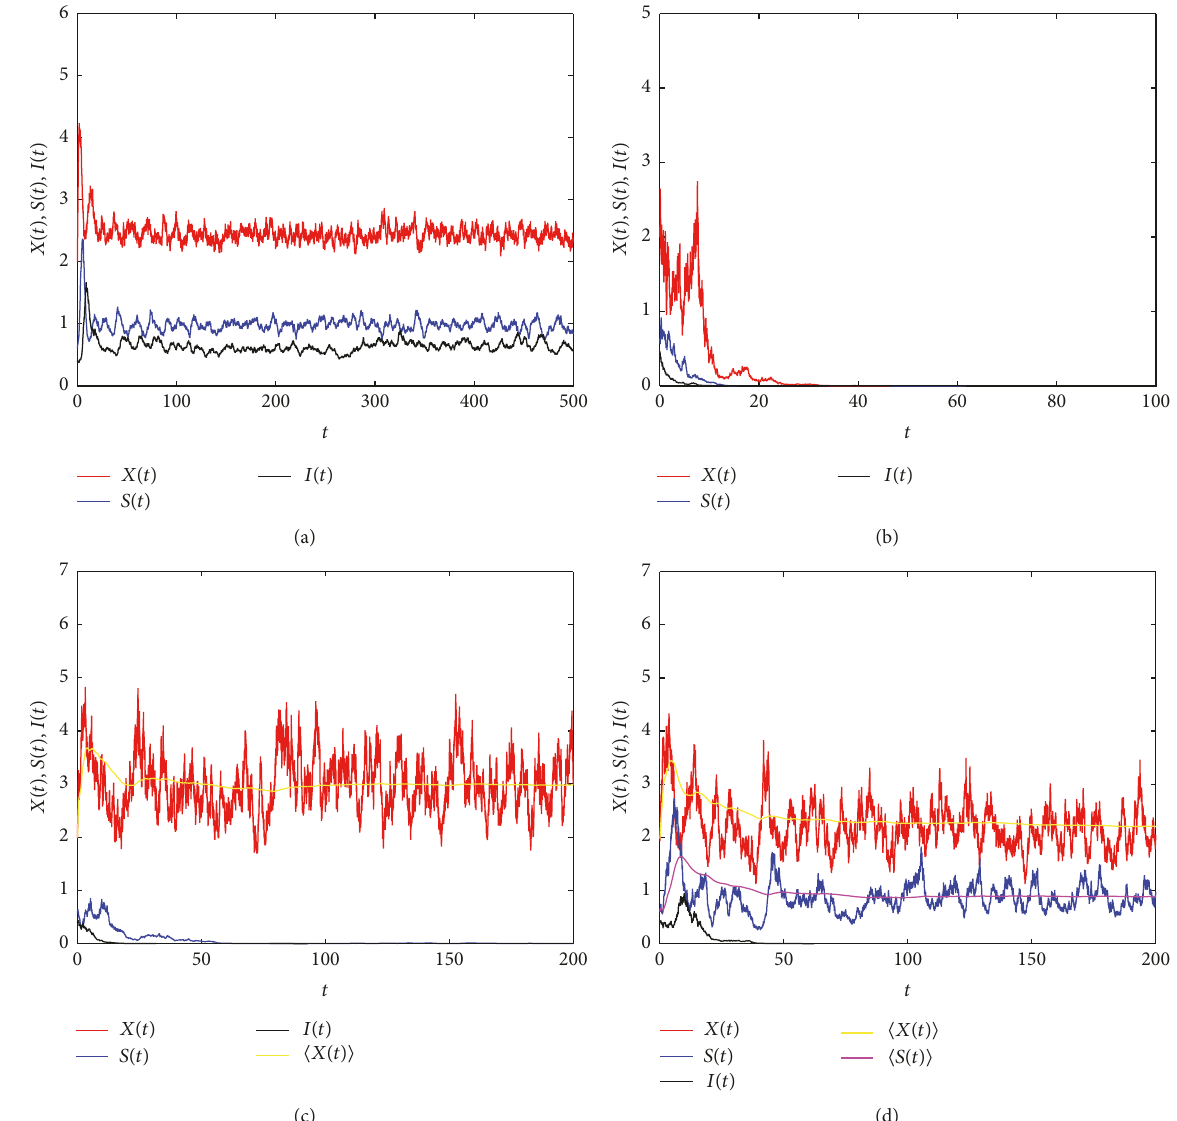
Figure 1: In (a), 𝛾 1 = 0 , 𝛾 2 = 0 , 𝛾 3 = 0 , and the species are permanent; in (b), 𝛾 1 = 2.2 , 𝛾 2 = 1.5 , 𝛾 3 = 1.2 , and then the species are extinct; in (c), 𝛾 1 = 0.5 , 𝛾 2 = 1.5 , 𝛾 3 = 1.2 , 𝑋(𝑡) is permanent, 𝑆(𝑡) and 𝐼(𝑡) are extinct, and lim 𝑡→∞ ⟨𝑋(𝑡)⟩ = 2.953 ; in (d), 𝛾 1 = 0.5 , 𝛾 2 = 0.5 , 𝛾 3 = 1.2 , 𝑋(𝑡) and 𝑆(𝑡) are permanent, 𝐼(𝑡) is extinct, lim ⟨𝑋(𝑡)⟩ = 2.144 , and lim ⟨𝑆(𝑡)⟩ = 0.892 𝑡→∞ 𝑡→∞